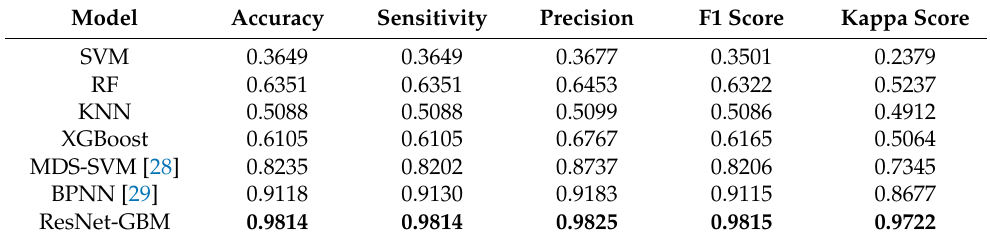
Table 7. Classification results of seven models in Experiment